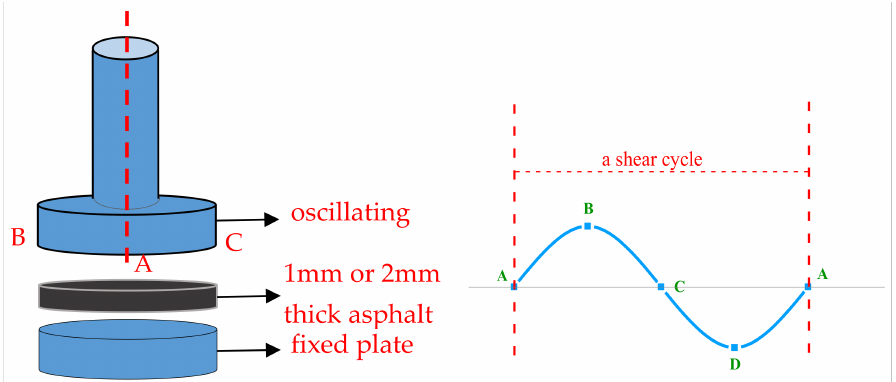
Figure 3. Drawing of dynamic shear